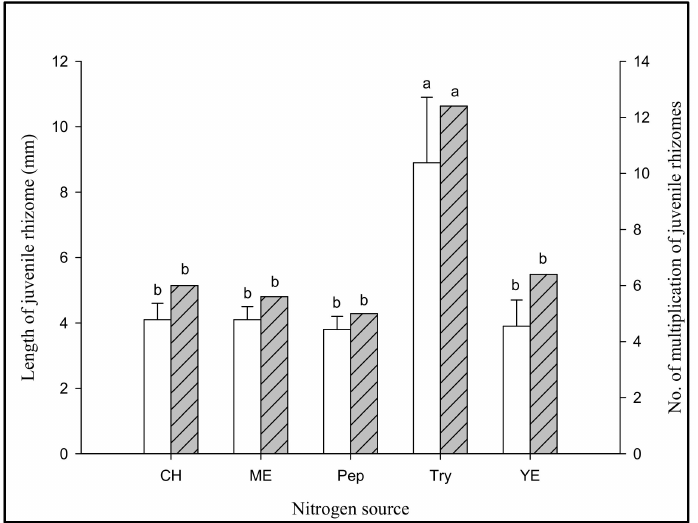
Figure 5. Effect of nitrogen source (1 g/L) on the growth and proliferation of G. elata juvenile rhizomes after 8 weeks in YH2 culture medium. Basal medium YH2: YH1 + 3.5 g/L gelrite (to replace 8 g/L agar) CH: casein hydrolysate; ME: malt extract; Pep: peptone; Try: tryptone; YE: yeast extract. Each value is expressed as mean ± SD (n = 5). Means followed by the different letter(s) are significantly different at p < 0.05 by Fisher’s protected LSD test. a,b Mean values with unlike letters were significantly